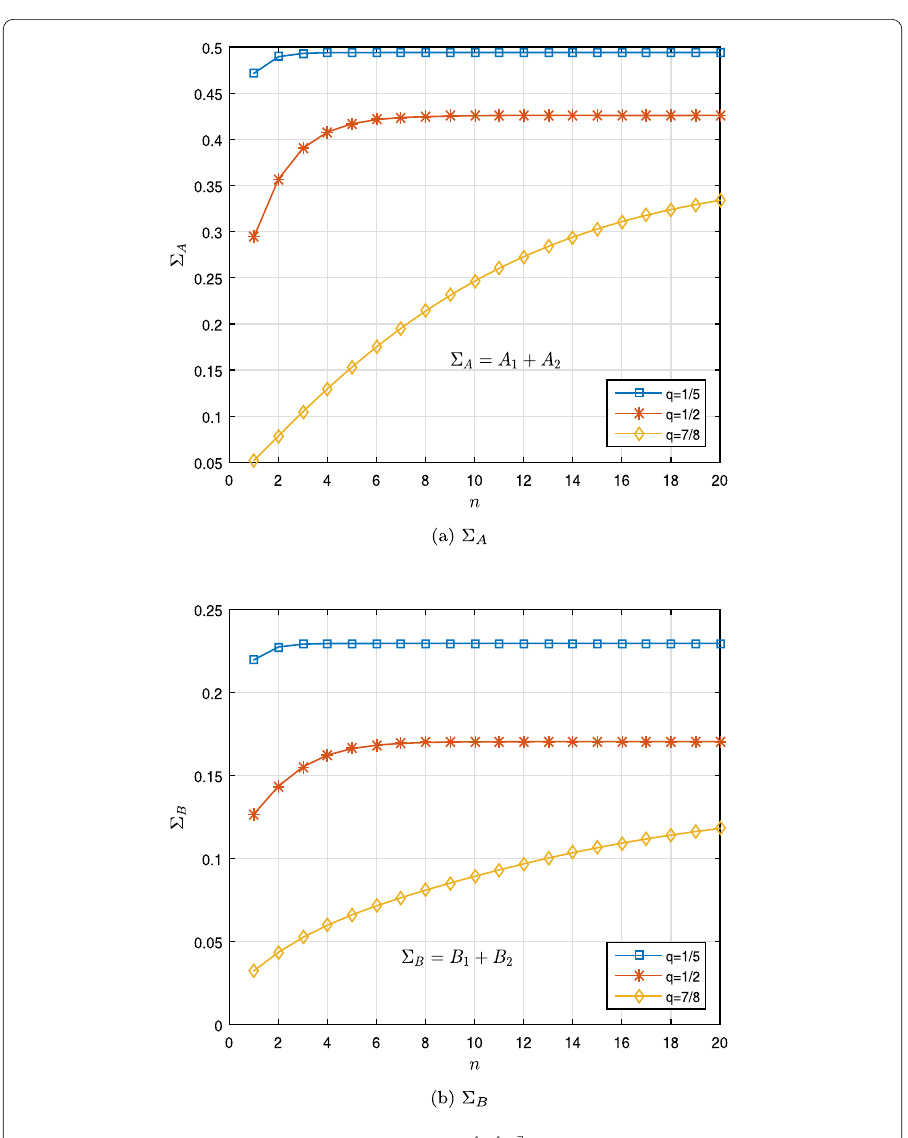
Figure 2 Graphical representation of (cid:17) A and (cid:17) B for q = 1